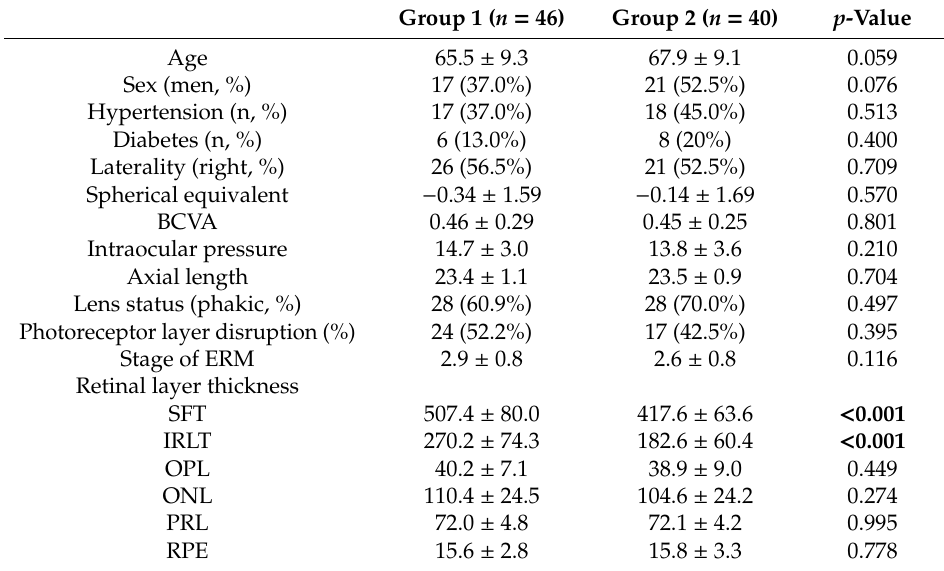
Table 1. Baseline characteristics and